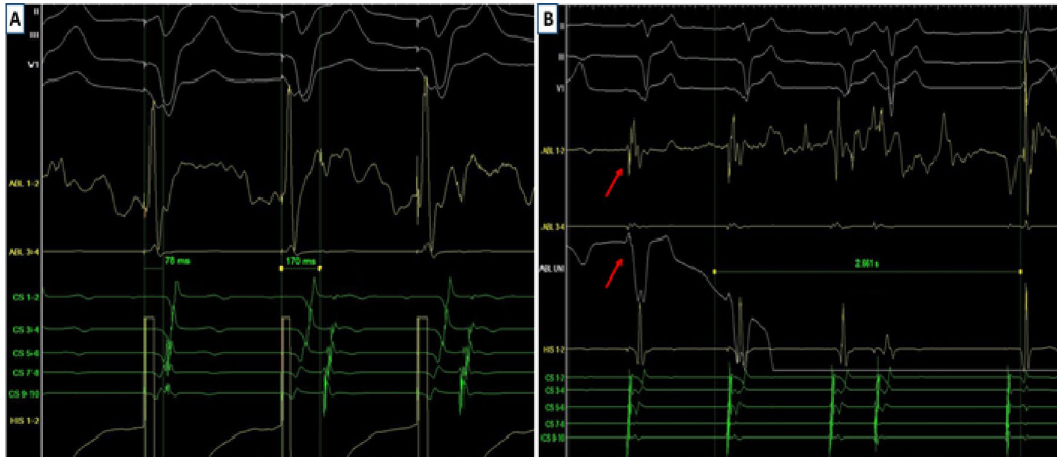
Fig. 4 Electrophysiology study in identical twins. A: Abolition of right posteroseptal accessory pathway in 3.7 s during ventricular pacing with increased ventriculoatrial interval from 78 to 170 ms in twin A. B: Abolition of right-sided midseptal anterograde accessory pathway in 2.6 s with classic atrioventricular fusion on ablation catheter (red arrows) in twin B. CS successful site of accessory pathway ablation; UNI